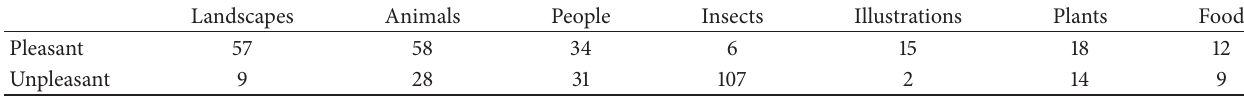
Table 5: Detailed pleasant/unpleasant categorizations of images.